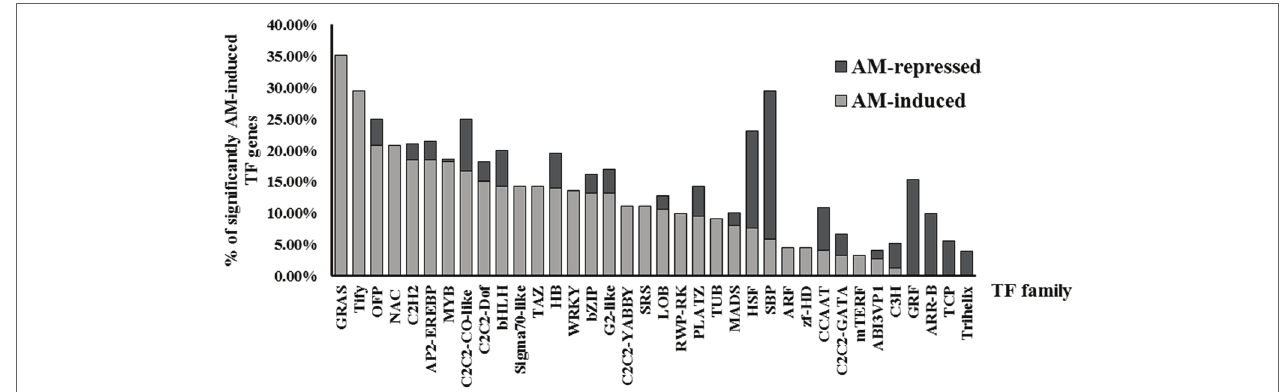
FIGURE 1 | Relative abundance of TF genes differentially regulated upon mycorrhization in tomato. Percentage of AM-repressed and AM-induced TF genes, with RNA-seq fold change < − or > 2 and p < 0.05, belonging to each TF gene family in